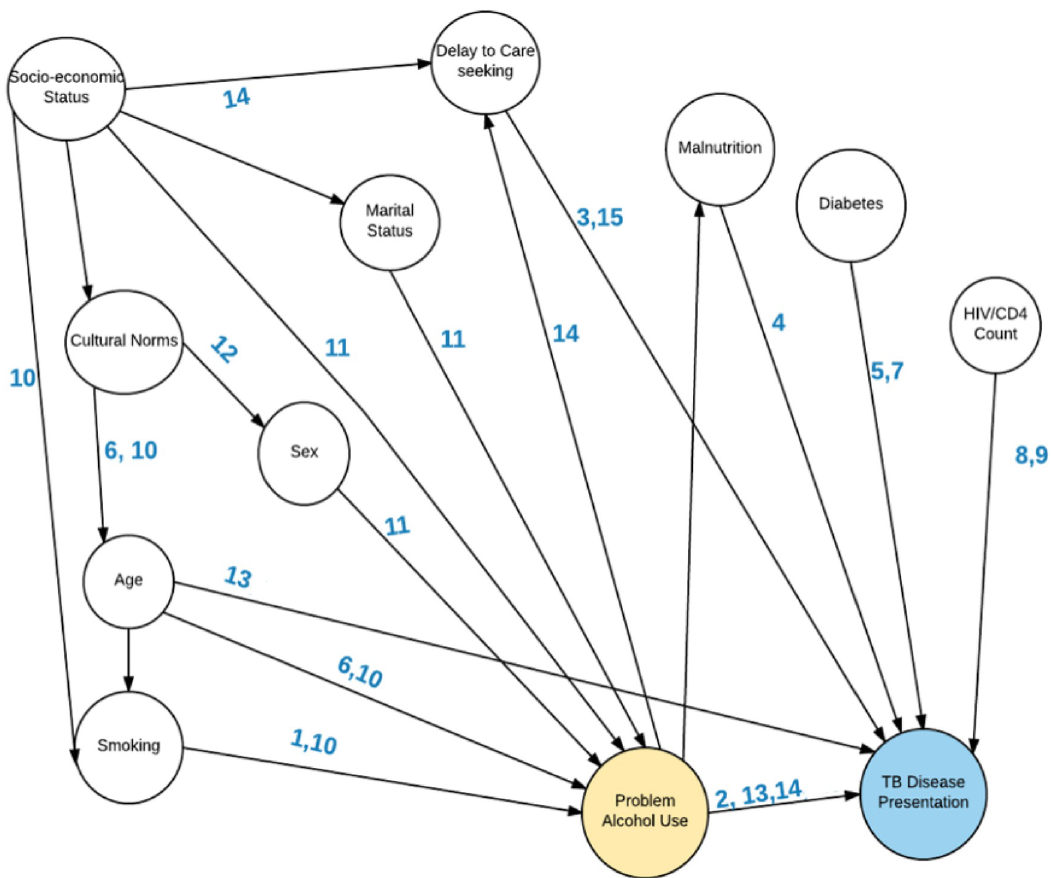
Fig 1. Directed Acyclic Graph (DAG) addressing factors related to alcohol use and tuberculosis disease presentation. Numbers on the arrows are citations in the reference list for this paper [41–49].